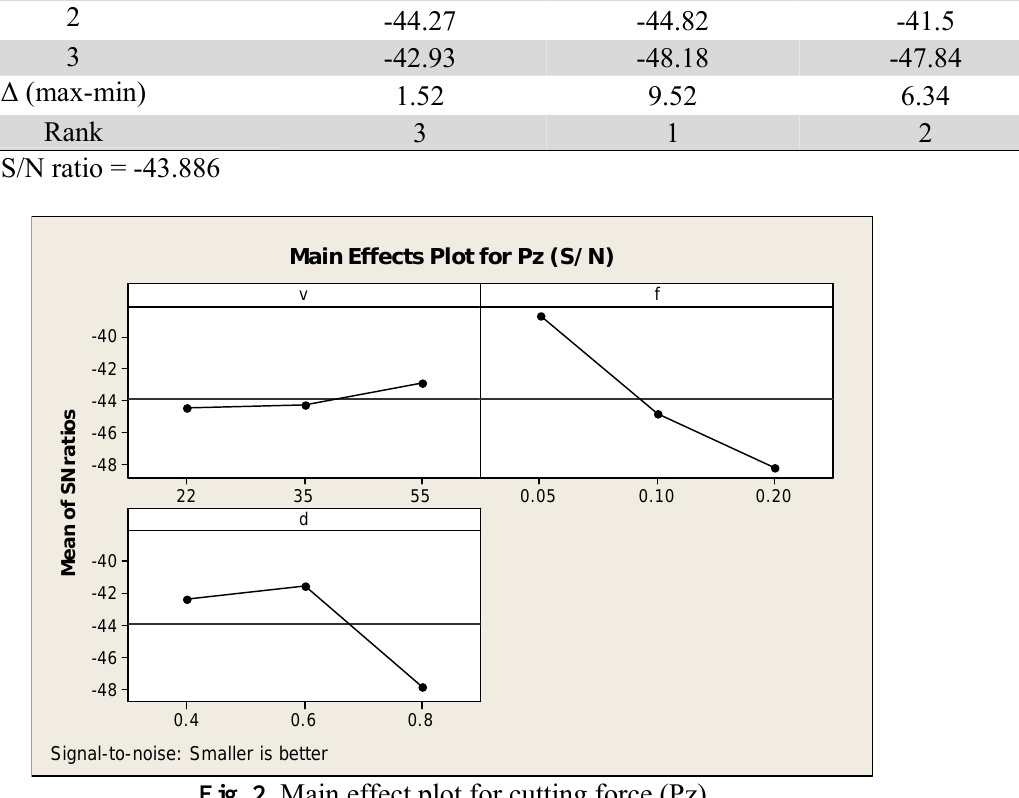
Fig. 2. Main effect plot for cutting force (Pz) Results of the verification experiment for cutting force Initial cutting